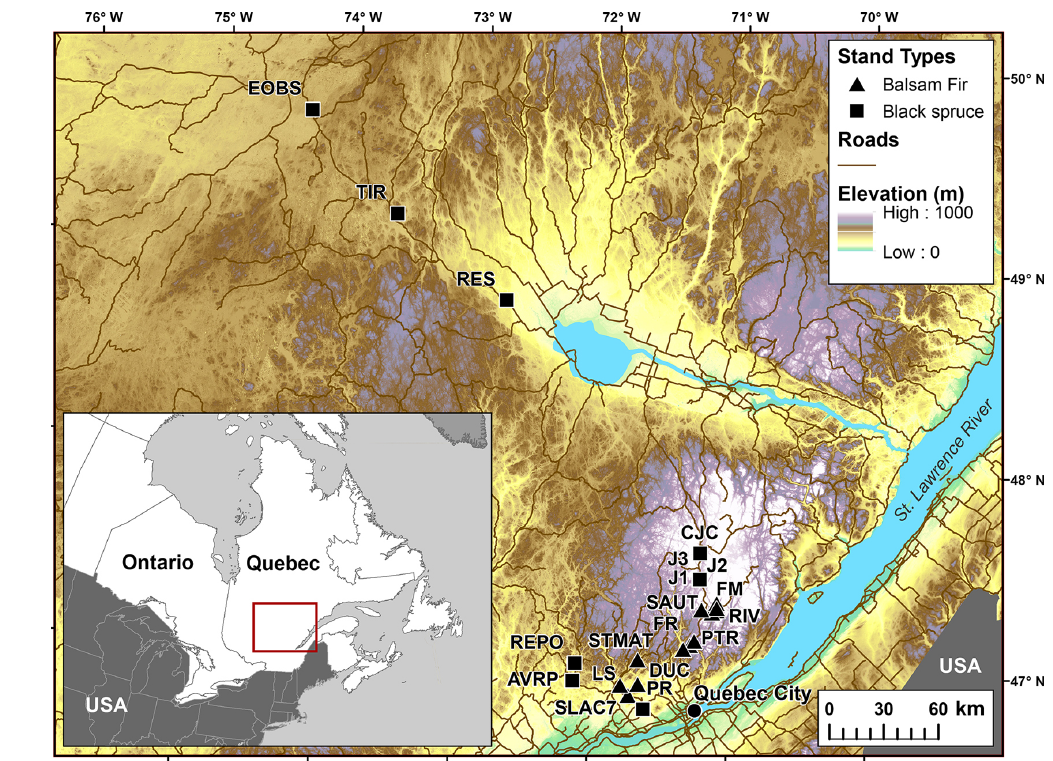
Figure 1. Location of the study sites showing how the temperature gradient is related to elevation and latitude. Data from Abrams et al.